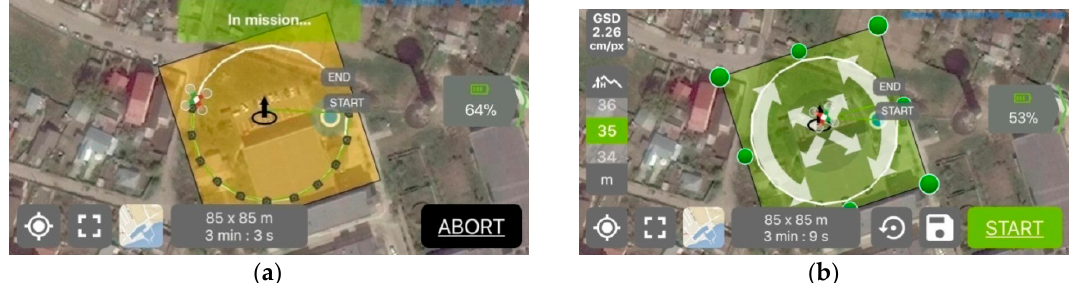
Figure 6. Screen shots during the UAS image acquisition over the 3D calibration field for digital cameras mounted on UAS platforms at ( a ) 28 m height and ( b ) 35 m height.